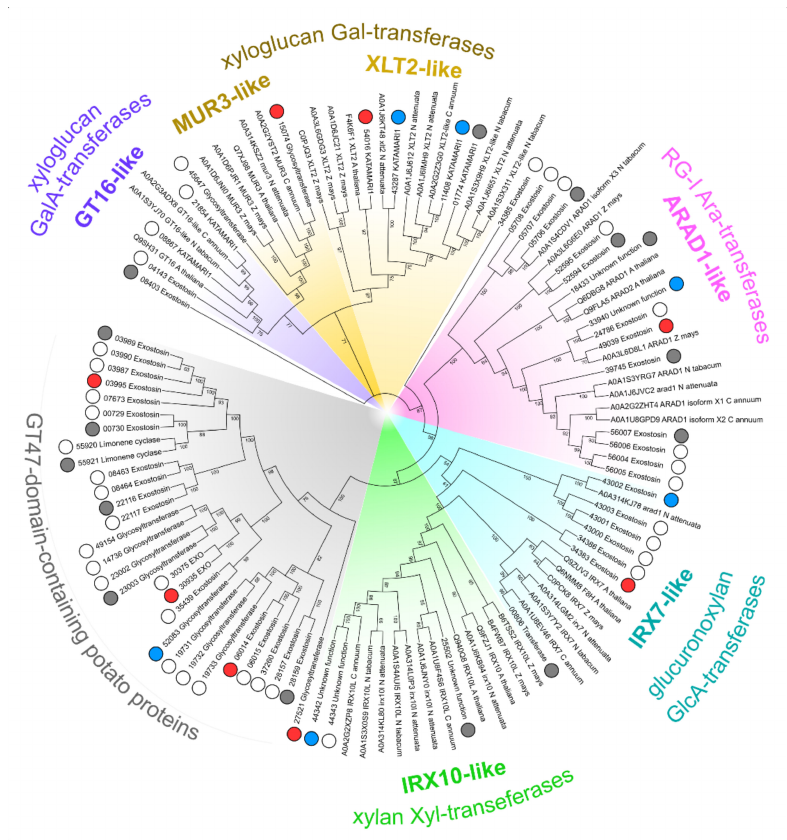
Figure 10. Phylogeny of potato glycosyltransferase 47 family (GT47) proteins and of a reference set of Arabidopsis thaliana, Capsicum annuum, Nicotiana attenuata, N. tabacum, and Zea mays GT47 proteins. The clades for GT47 functional subgroups are marked in colors. Potato proteins are indicated with circles according to the expression pattern of corresponding genes in Pectobacterium atrosepticum -infected vs. non-infected potato plants: red—upregulated; blue—downregulated; grey— non-DEG; empty—not expressed in our study. The UniProt IDs of non-potato species proteins and the corresponding taxa names are given in the leaf names. For potato proteins only parts of PGSC IDs are given; the “PGSC0003DMP4000” symbols, the constant part at the beginning of all presented PGSC protein IDs, were omitted for the sake of